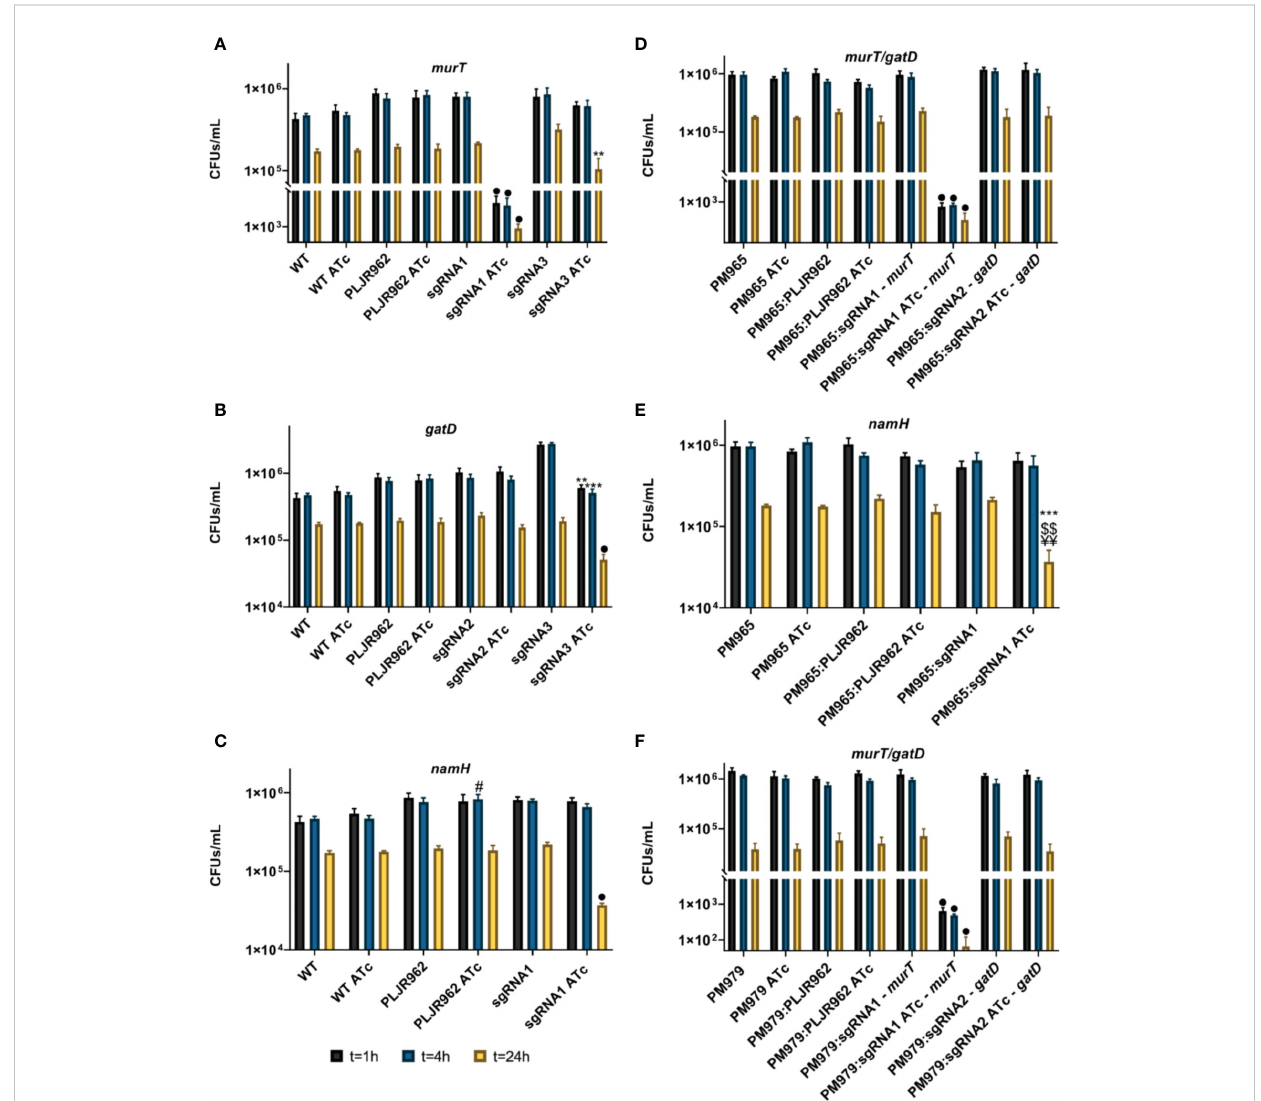
FIGURE 8 Logarithmic representation of the mean of bacterial survival, with/without ATc, in CFUs/mL, after infection and disruption of J774.A1 macrophages (n=3). (A – C) Single mutants: (A) murT knockdown mutants; (B) gatD knockdown mutants; (C) namH knockdown mutants; (D, E) Double mutants: (D) murT / gatD knockdown mutants; (C) namH knockdown mutants; (F) Triple mutants, murT / gatD knockdown mutants. Error bars show the standard error of the mean. Multiple comparisons were made using one-way ANOVA: * P < 0.05; ** P < 0.01; *** P < 0.001. Signi fi cant differences are indicated with symbols: # comparing to control strain WT ATc, ¥ comparing to the controls PM965 ATc or PM979 ATc; $ comparing to M. smegmatis WT/PM965/PM979:PLJR962 ATc, * comparing to the respective uninduced strain. The (cid:129) symbol indicates a highly signi fi cant difference ( P < 0.0001) from all